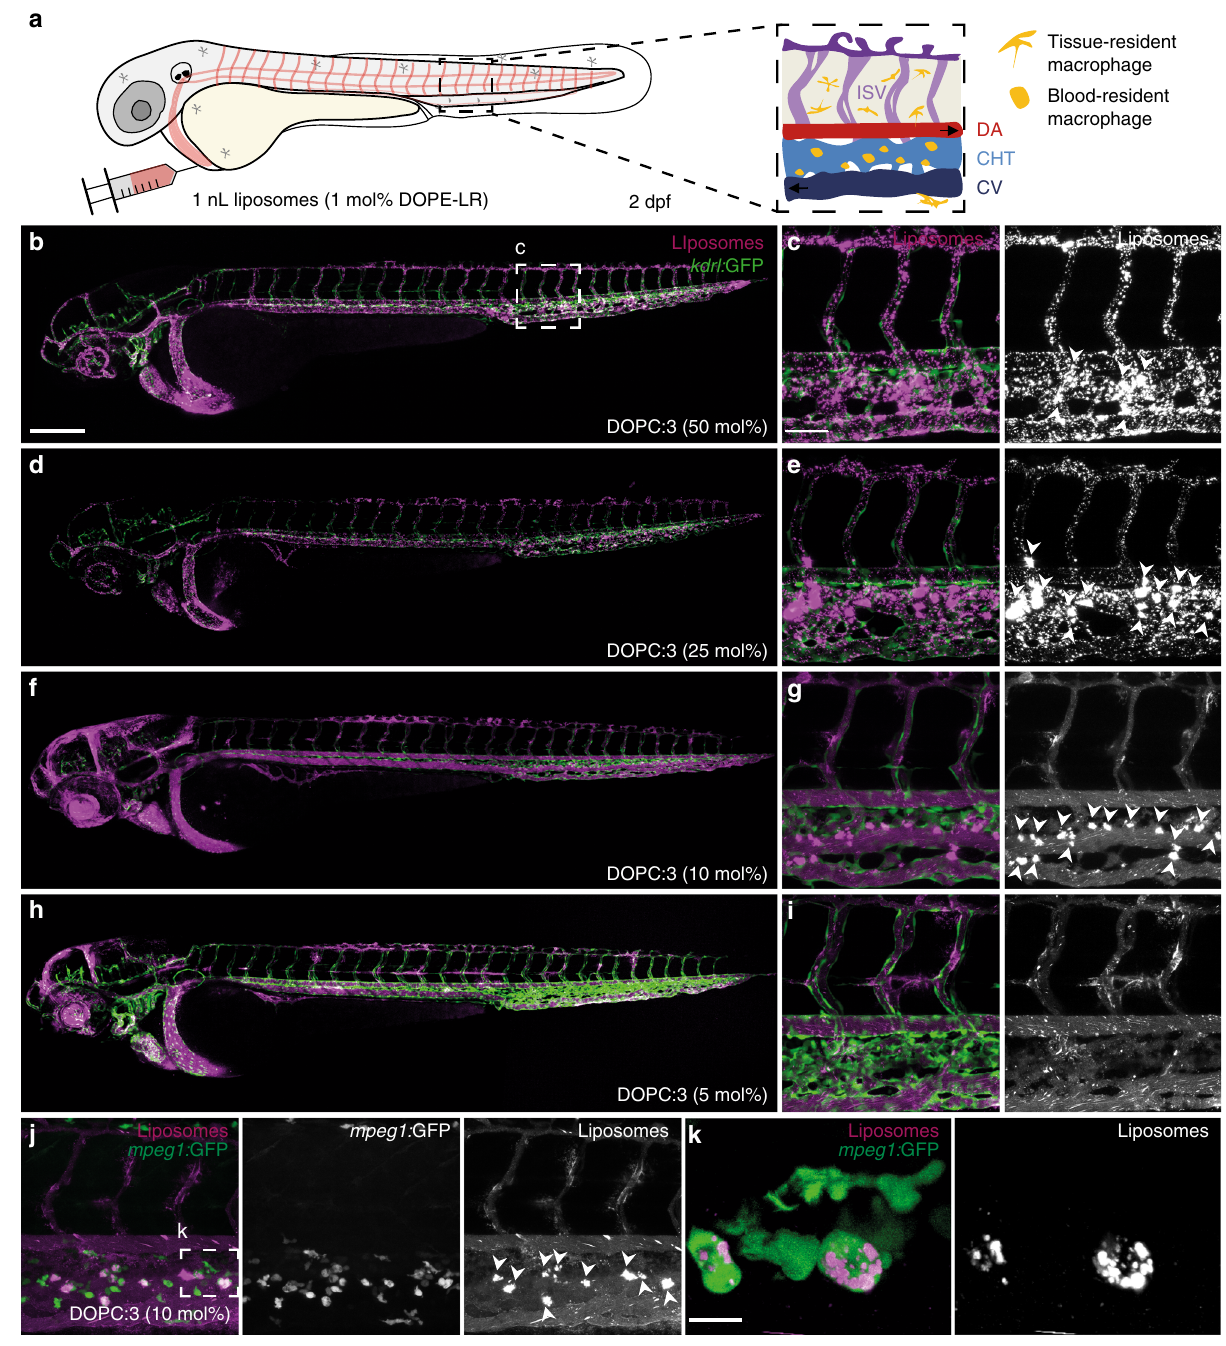
Fig. 3 Biodistribution of cationic, DOPC:3 liposomes in embryonic zebra fi sh. a Schematic showing the site of microinjection within a zebra fi sh embryo, two days post-fertilisation (dpf). Boxed region showing the organisation of blood vessels/macrophages within the tail of the embryo. DA dorsal aorta, CHT caudal hematopoietic tissue, CV caudal vein, ISV intersegmental vessel. Black arrows indicate direction of blood fl ow. b – i Biodistribution of DOPC liposomes containing cholesterylamine, 3 , at varying mol%. Whole embryo (×10 magni fi cation) and tissue level (×40 magni fi cation) views of liposome distribution in kdrl:GFP transgenic embryos, stably expressing GFP in all endothelial cells, at 1 hpi. White arrowheads indicate apparent liposome uptake within blood resident macrophages, based on location and cell morphology. j , k Tissue and cellular (×63 magni fi cation) level views of DOPC: 3 (10 mol% 3 ) liposome distribution in mpeg1:GFP transgenic embryos, stably expressing GFP in all macrophages, at 1hpi. Extensive fl uorescence co-localization of liposomes and transgenic GFP con fi rmed the uptake of DOPC: 3 (10 mol% 3 ) liposomes in blood resident macrophages of the zebra fi sh embryo. Slight variations in the positions of macrophages (between j and k ) are due to macrophage migration during the time taken to change magni fi cation settings on the confocal microscope. All liposomes b – k contained 1 mol% fl uorescent lipid probe, DOPE-LR, for visualisation. Scale bars: 200 μ m (whole embryo); 50 μ m (tissue level); 10 μ m (cellular